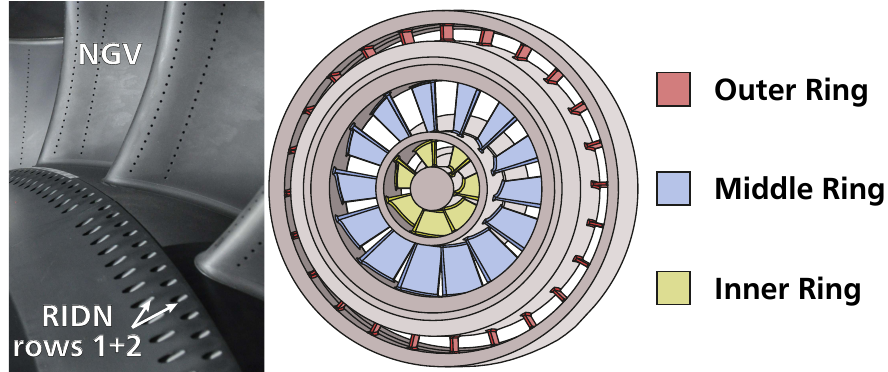
Figure 1. Test rig view on Rear Inner Discharge Nozzle (RIDN) coolant injection and the nozzle guide vane (NGV) row ( left ) and schematic of the Large Scale Turbine Rig (LSTR) swirler ( right